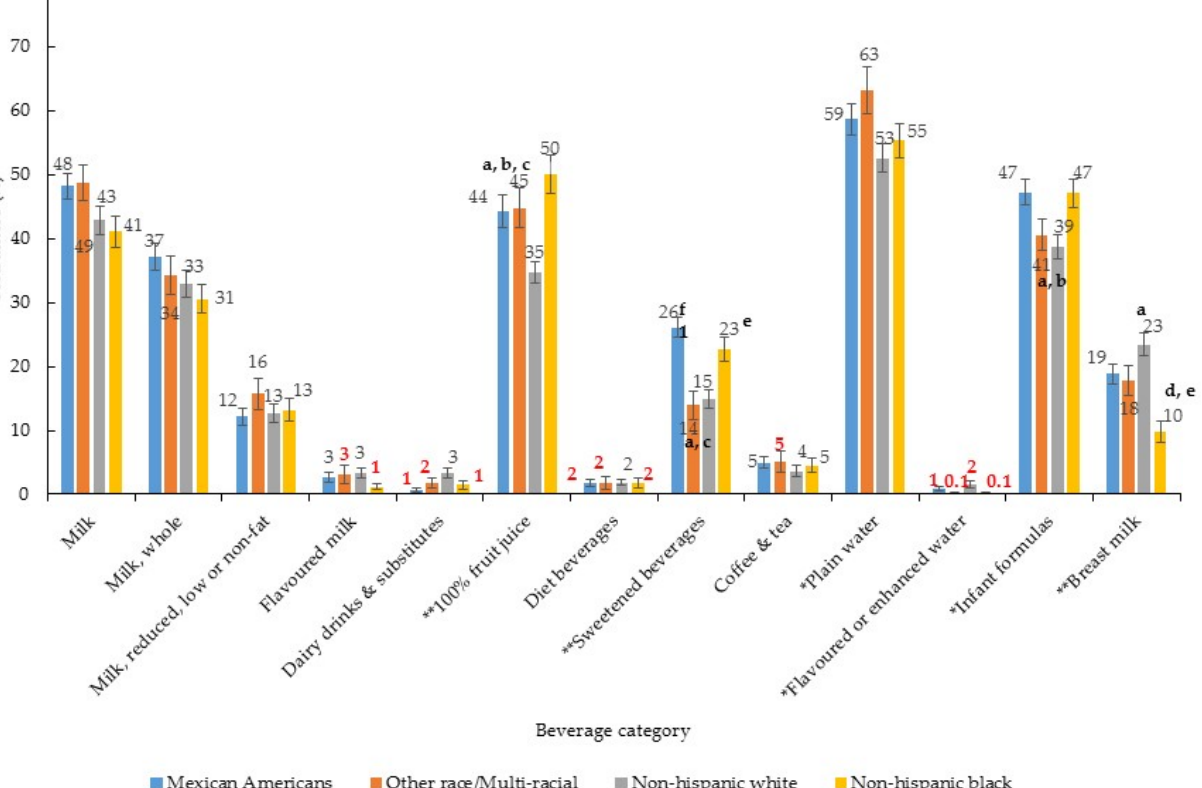
Figure 3. Proportion (%) of children consuming each type of beverage by race/ethnic group ( n = 2740) 1,2 . 1 Error bars represent ± 1 SE. Those bolded in red are statistically unreliable, relative standard error ≥ 30% [24]; 2 Chi-square test to assess difference in proportions * p < 0.01, ** p < 0.001. Where significant, logistic regression with Bonferroni adjustment for multiple comparisons was used to assess differences between sub-groups; a Non-HW vs. Non-HB p < 0.05; b Non-HW vs. MA p < 0.05; c Non-HW vs. Non-HA/OH/OR p < 0.05; d Non-HB vs. MA p < 0.05; e Non-HB vs. Non-HA/OH/OR p < 0.05; f MA vs. Non-HA/OH/OR p < 0.05.